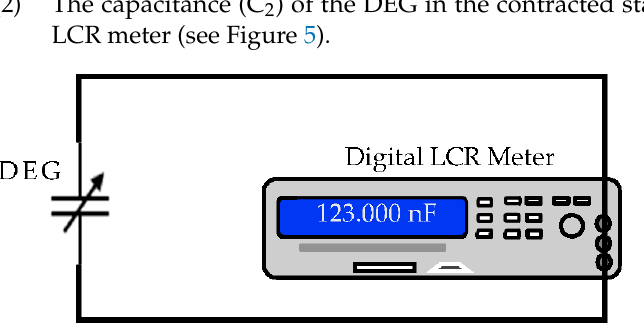
Figure 5. Measurement circuit of the capacity of the DEG in the contracted state.